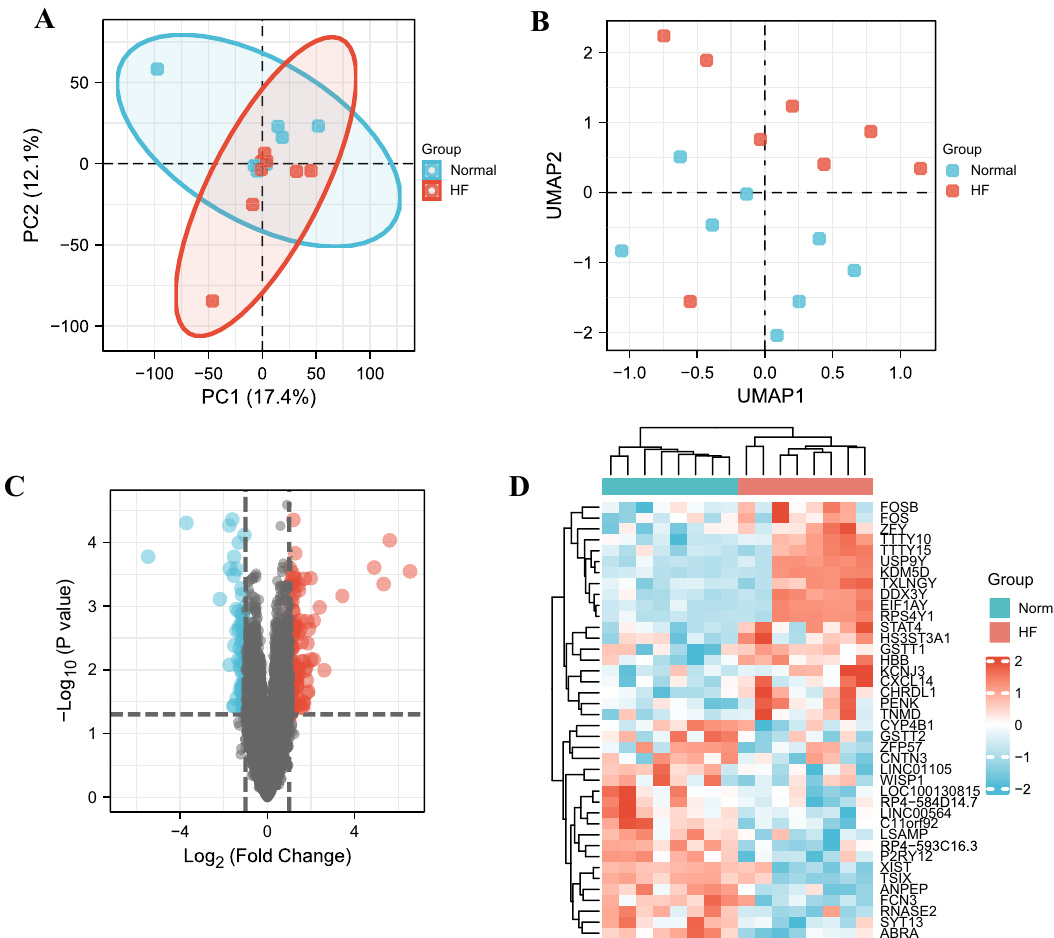
Figure 2. The PCA plot, UMAP plot, Volcano plot and Heatmap plot of gene expressions for 2 selected GEO Database with a screening criteria of |log2 FC|≥ 1 and adjust p value < 0.05. (( A ) PCA plot; ( B ) UMAP plot; ( C ) Volcano plot; ( D ) Heatmap plot. PCA: Principal Component Analysis; UMAP: Uniform Manifold Approximation and Projection; Normal: Normal Group; HF: Heart Failure Group).